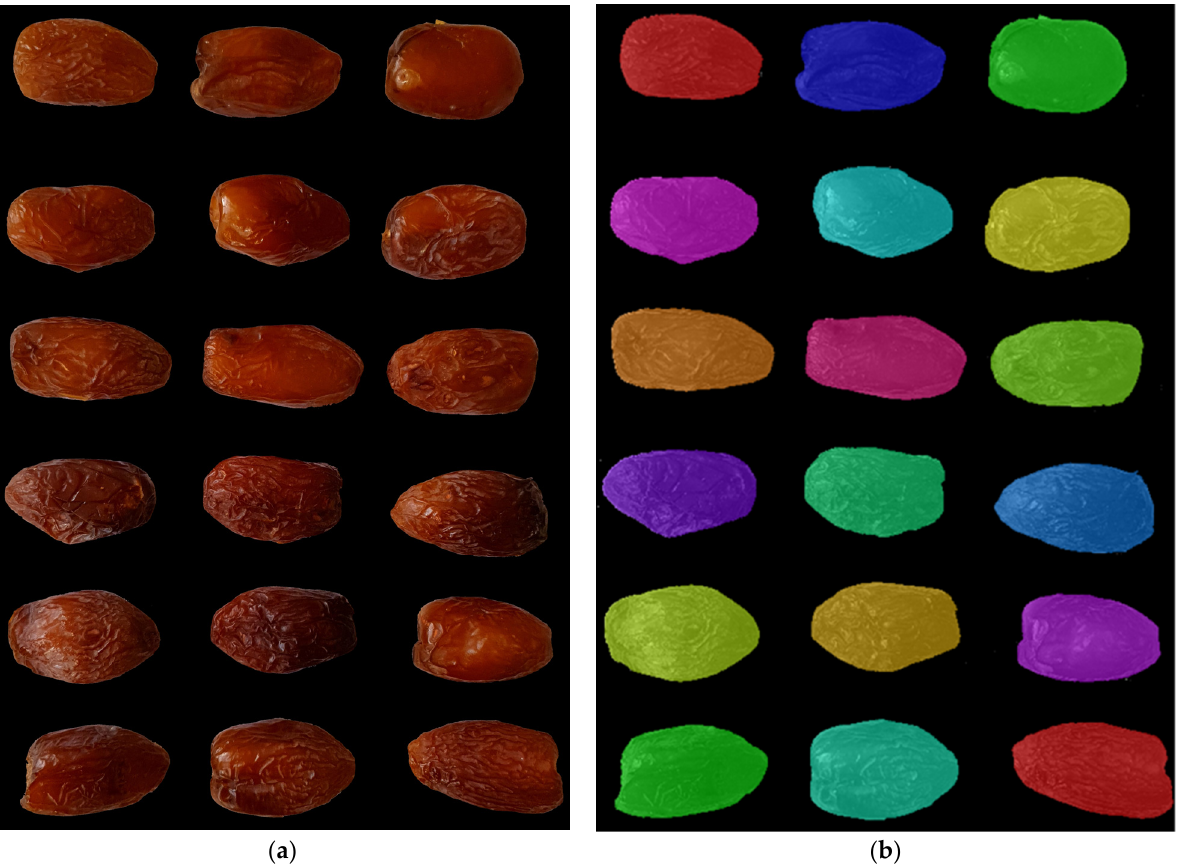
Figure 1. The original image of ‘Mejhoul’ date palm fruit ( a ) and image with overlaid regions of interest (ROIs) ( b ).